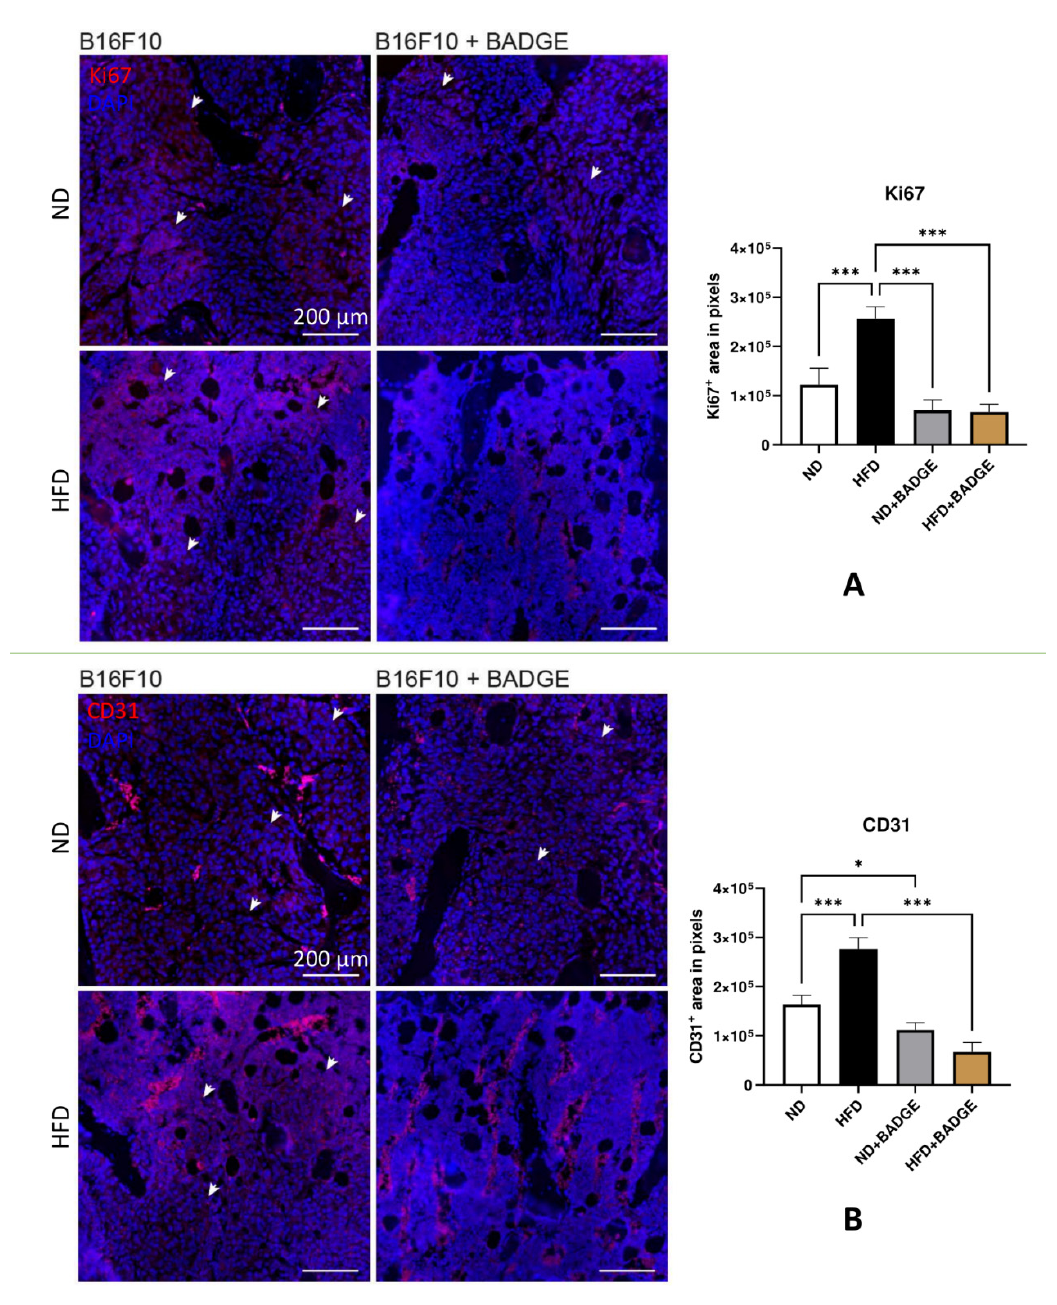
Figure 5. Immunofluorescence staining (mouse) for proliferation and vascularization markers in bone metastases after inoculation of B16F10 melanoma cells. ( A ) Bone slides of ND, HFD, ND + BADGE, and HFD + BADGE animals with tumors were stained for the proliferation marker Ki-67 (red). Cell nuclei were counterstained with DAPI (blue). ( B ) Bone slides of ND, HFD, ND + BADGE, and HFD + BADGE animals with tumors were stained for the vascularization marker CD31 (red). Cell nuclei were counterstained with DAPI (blue). White arrows indicate either Ki67- (top) or CD31 (bottom) positive areas. * p < 0,05; *** p < 0,001. Scale bar = 200 µm. Bone metastasis slides from mice inoculated with B16F10 melanoma cells were stained for markers of proliferation (Ki-67) or vascularization (CD31). Analysis of the slides revealed the positively stained area. Here, BADGE treatment decreased Ki67 pro- liferation ( p > 0.05, ND + BADGE; p < 0.001, HFD + BADGE) and CD31-vascularization ( p = 0.041, ND + BADGE; p < 0.001, HFD + BADGE) signal predominantly in HFD-fed mice. Representative images of immunofluorescence staining of paraffin-embedded mouse bones under different conditions are shown in Figure 5.